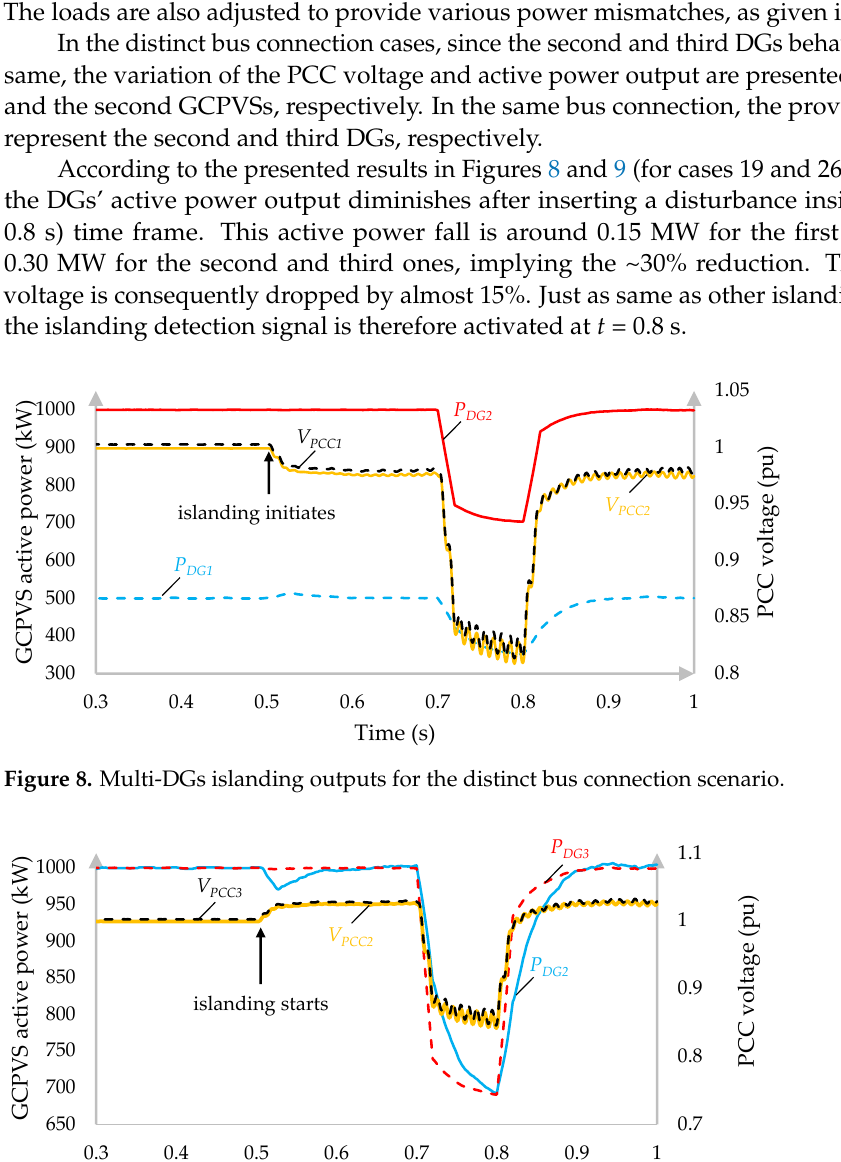
Figure 7. Results of islanding events under Q f =1.5.